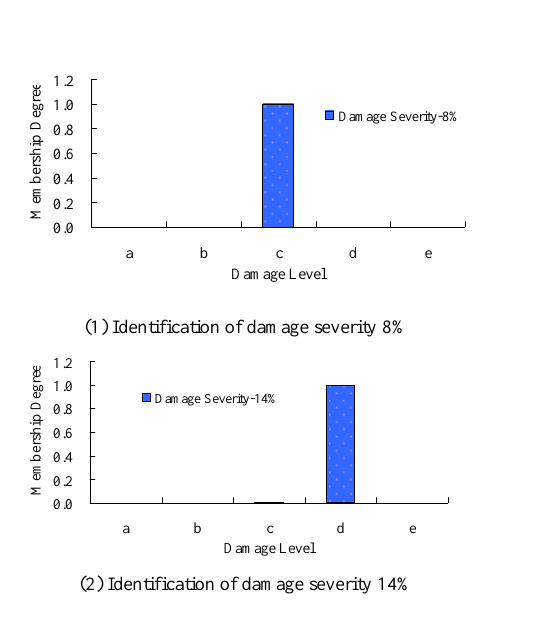
Fig. 9. Damage identification of case